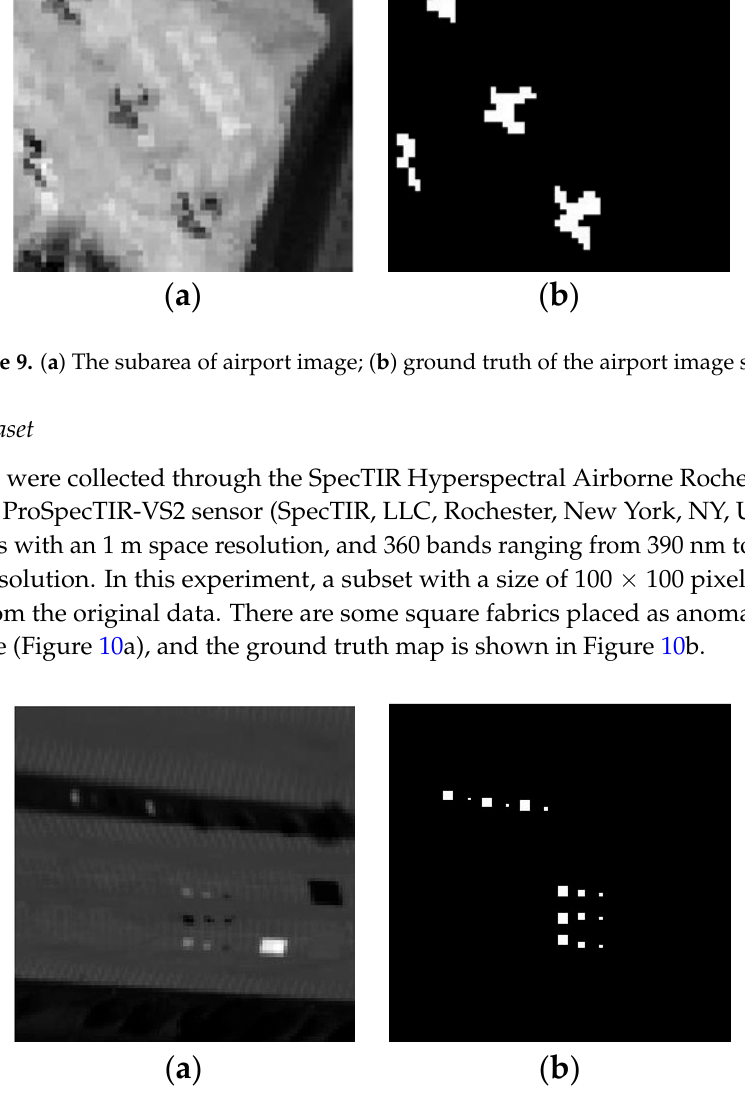
Figure 10. ( a ) The subarea of SpecTIR image; ( b ) ground truth of the SpecTIR image scene.